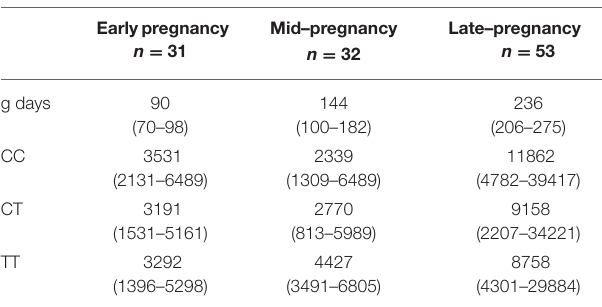
TABLE 3 | Detailed data of sFlt-1 (pg/mL) measurements stratified into fetal FLT1 rs4769613 T/C genotype of the 116 serum samples drawn during early, mid, and late